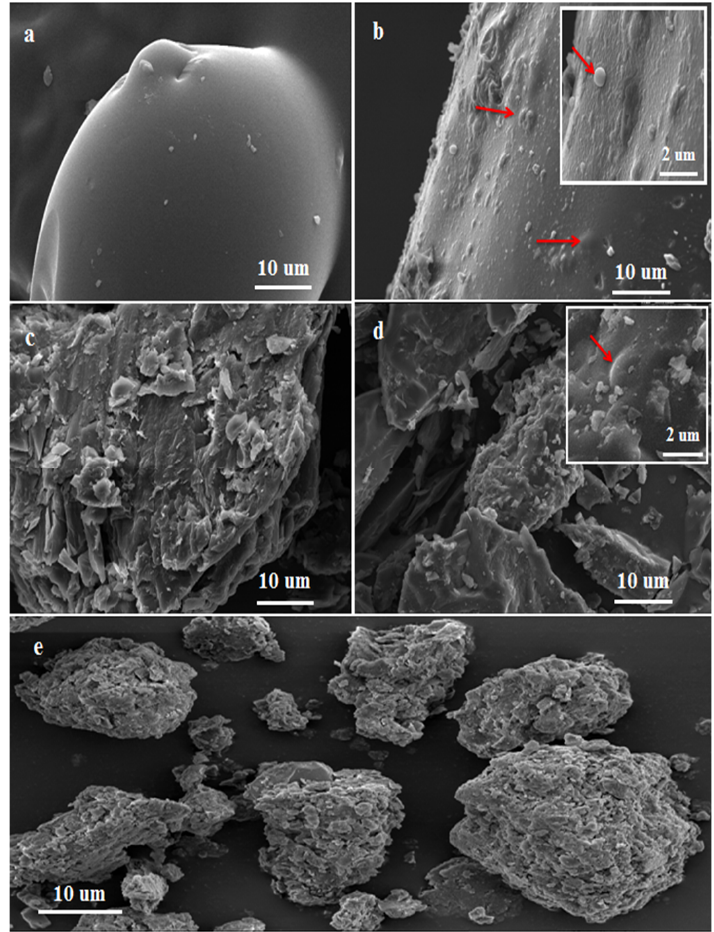
Figure 5. SEM images of Ros-Lim ( a ), Ros-Lim / Mag-CTA + 10% ( b ), Ros-Lim / Mag-CTA + 5% ( c ), Ros-Lim / Mag-CTA + 1% ( d ) and Mag-CTA + ( e ).